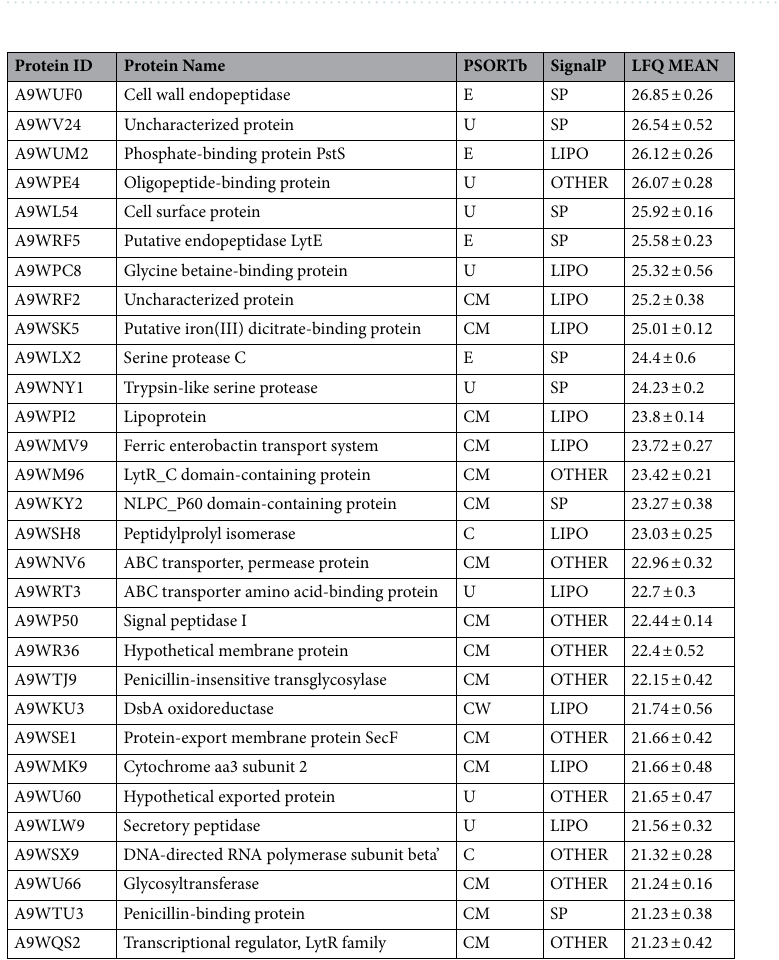
Figure 3. Transmission electron micrographs of isolated and purified membrane vesicles of R. salmoninarum .